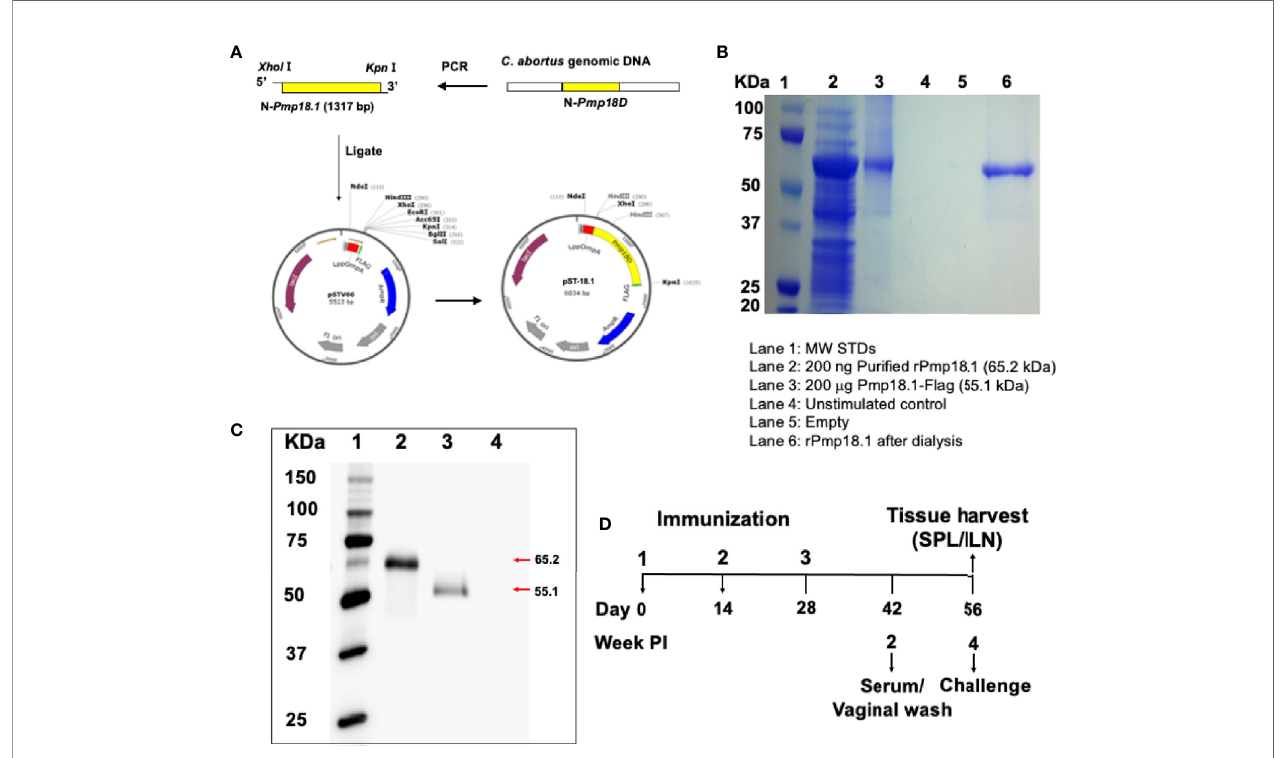
FIGURE 1 | Construction of vaccine vectors and expression of recombinant proteins. (A) The pST-18.1 vaccine vector was constructed by genetically inserting the ampli fi ed 1317 bp fragment of the N-terminal Pmp18D coding sequence in frame with the N-terminal LppOmpA and C-terminal FLAG in plasmid vector pSTV66. The pET-18.1 expression vector was similarly constructed by inserting the 1317 bp fragment into vector pET-32a and rPmp18.1 was puri fi ed using the Ni-NTA Puri fi cation System. (B) Coomassie stained SDS-PAGE gel. Lane 1, MW markers; Lane 2, 200 ng of puri fi ed rPmp18.1; Lane 3, 200 µg of Pmp18.1 expressed from plasmid pST-18.1; Lane 4, Unstimulated control; Lane 5, Empty; Lane 6, PBS dialyzed rPmp18.1. (C) Protein expression was detected by immunoblotting analysis using puri fi ed rabbit anti-Pmp18D polyclonal antibody. Lane 1, MW markers; Lane 2, puri fi ed rPmp18.1; Lane 3, rPmp18.1-Flag fusion protein expressed from plasmid, pST-18.1; Lane 4, Empty. (D) Schematic diagram of the experimental design outlining the immunization, challenge, and sample collection